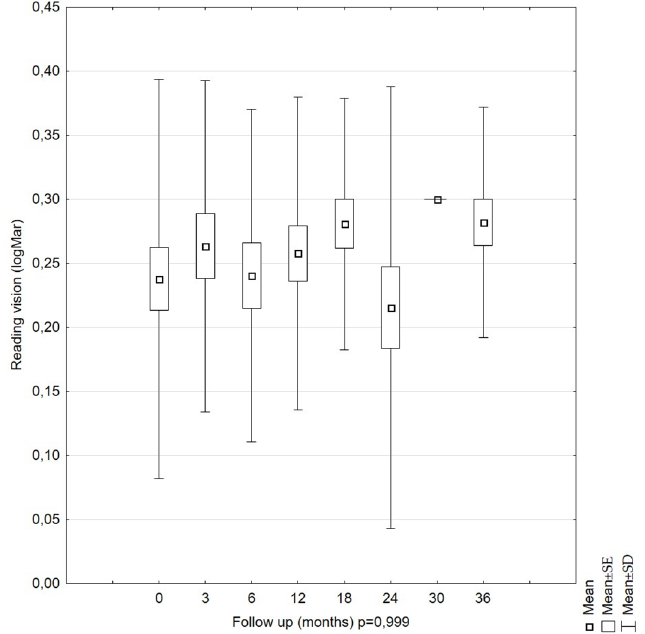
Figure 8. Mean reading vision (RV) values in LMH patients during the 36-month follow-up period. The RV remained stable over the whole follow-up period.